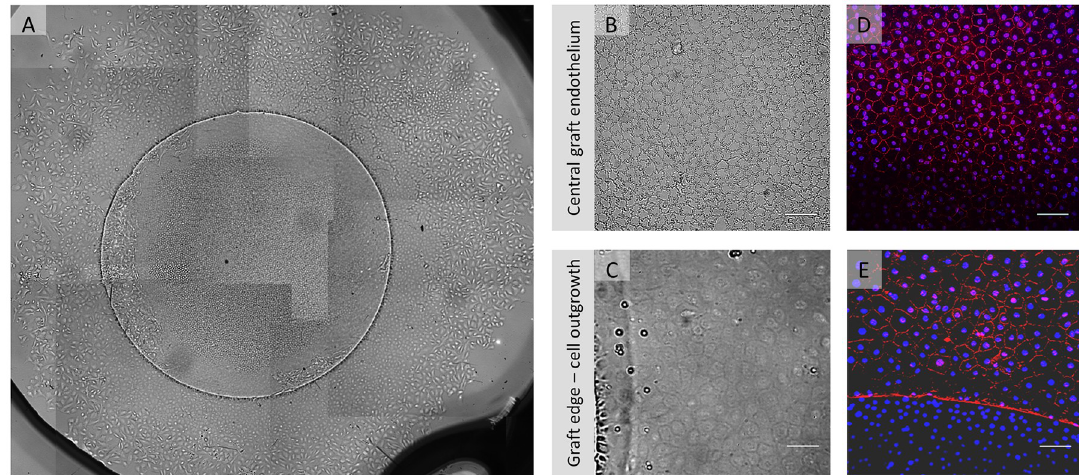
Fig 5. Example of in vitro endothelial cell migration from a gel-cultured 4mm graft. (A) Light microscopy overview collage (50x magnification) of a 4 mm DMEK graft after 17 days in gel culture showing uniform cell migration from all around the graft. (B) Light microscopy image showing central graft endothelium and (C) graft edge (bottom of the image) from where migration was directed as a confluent cellular monolayer. (D, E) Fluorescence microscopy images showing expression of ZO-1 (red signal) counterstained with DAPI (blue signal) in the graft center and in the migrated monolayer. The absence of ZO-1 stained cell borders in the lower part of image 5E can be attributed to the fact that cells in this area reside on the graft and are elevated as compared to the new cell monolayer. Therefore, the cells on the graft have an elevation of about 10 μ m (on the Descemet membrane) when compared to the migrated cells on the glass cover slide and therefore appear out of focus. Scale bars: 100 μ m.